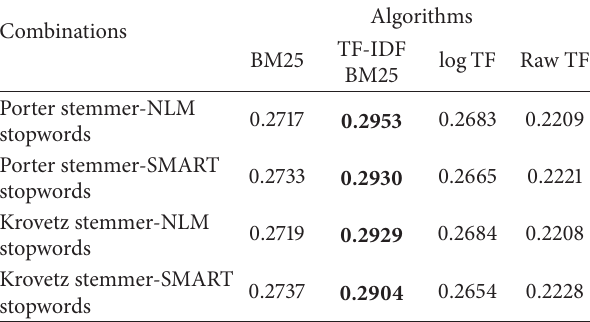
Table 7: MAP values to retrieving in Abstract, Title, and MeSH fields using different weighting algorithms.